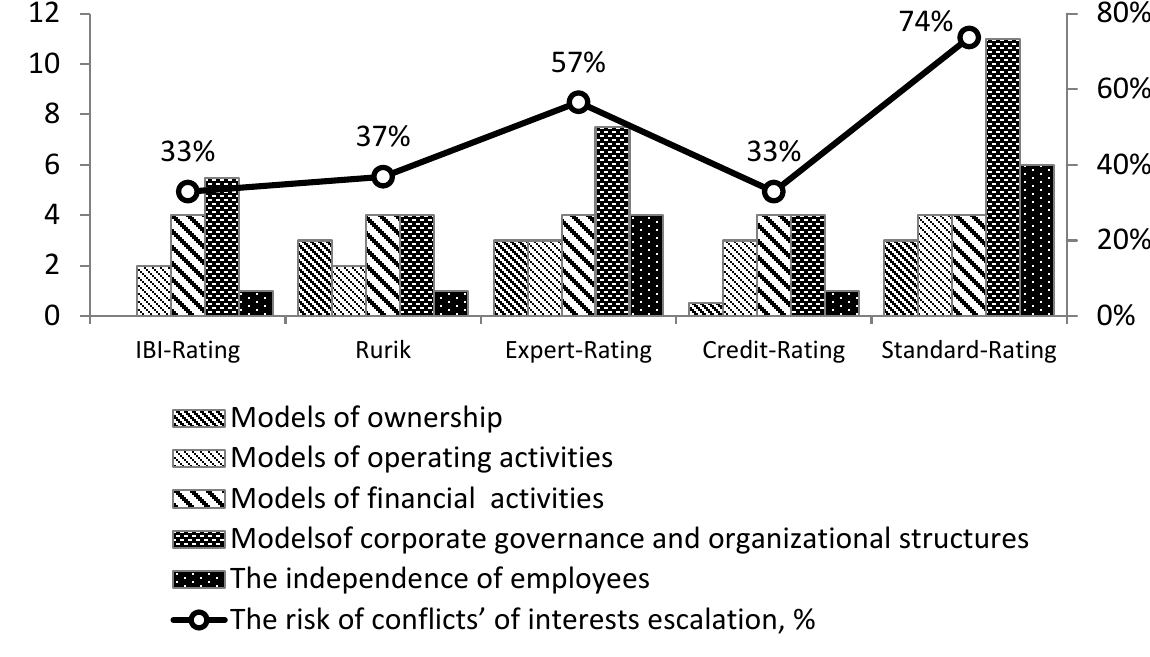
Figure 1. The total number of detected signals about the threat of conflicts’ of interest escalation in the activities of Ukrainian CRAs (at the beginning of